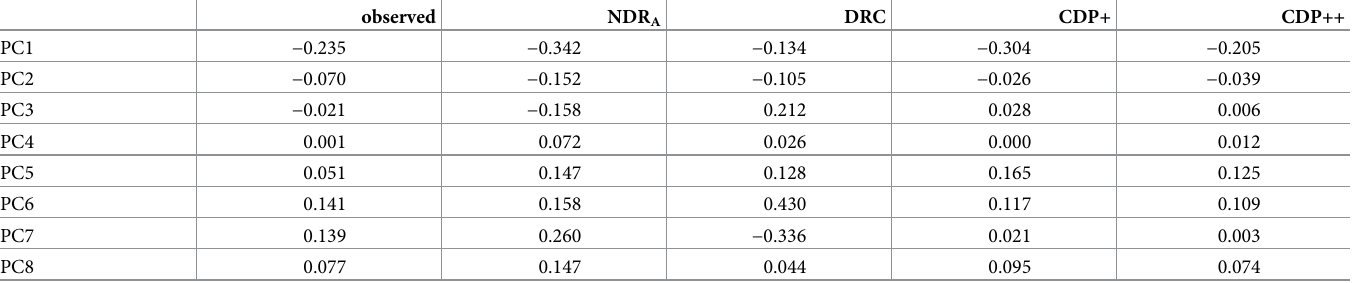
Table 5. Results of a principal components analysis on the 16 dimensional space described by the predictors. Listed are β coefficients for the first 8 principal